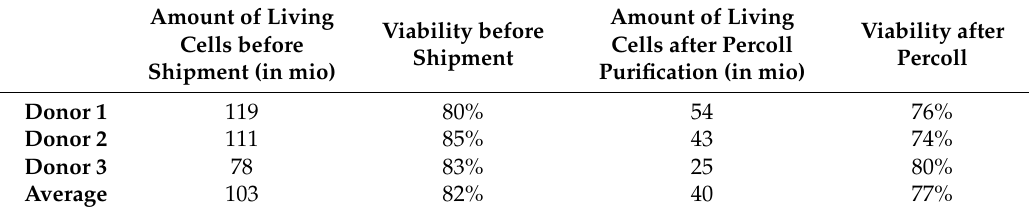
Table 3. Loss of living hepatocytes by shipping and subsequent purification.